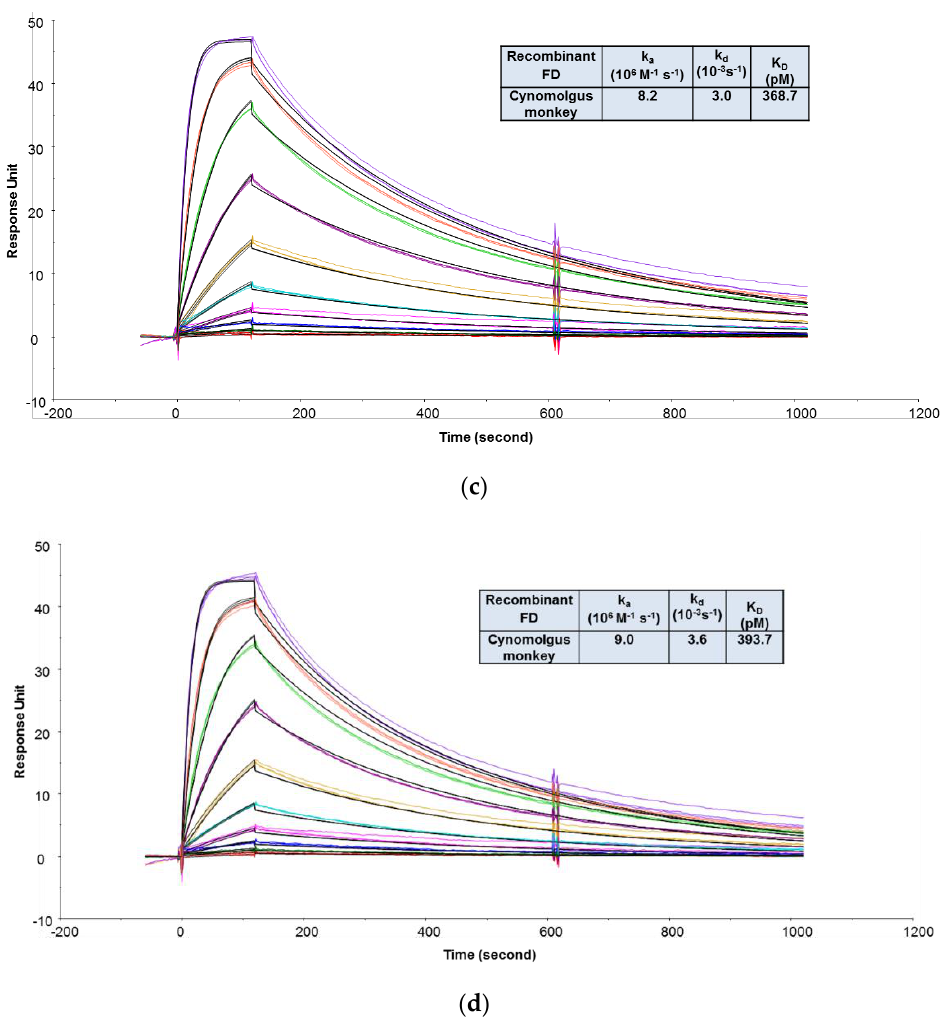
Figure 3. Representative sensorgrams of concentration-dependent binding of recombinant human FD to CCFD9260S ( a ) and anti-FD Fab ( b ), and recombinant cynomolgus monkey FD to CCFD9260S ( c ) and anti-FD Fab ( d ) at 37 ◦ C. Note: Black solid lines are fitted curves using a 1:1 binding model, and colored lines are the actual data. Concentrations of recombinant FD (from bottom to top) ranging from 0.02 to 10 nM were run in triplicate. The sensorgrams were generated after in-line reference cell correction followed by buffer sample subtraction.